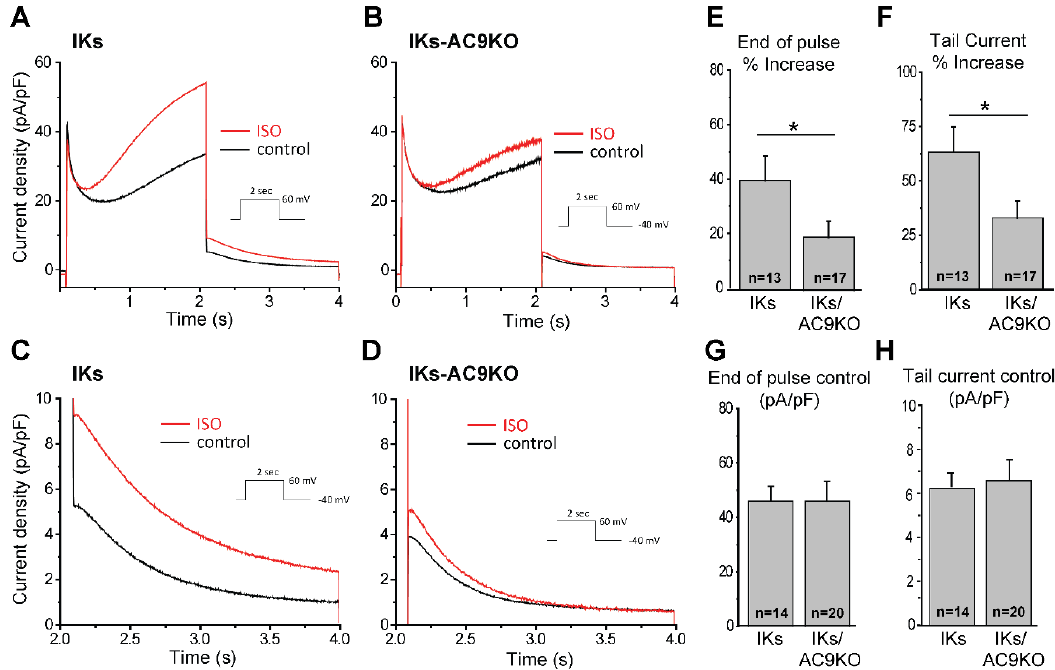
Figure 3. Deletion of AC9 dampens isoproterenol stimulation of I Ks . Representative traces of I Ks recordings in ventricular myocytes isolated from IKs ( A ) and IKs-AC9KO mice ( B ) before (control) and after perfusion of isoproterenal and okadaic acid (ISO). Enlargement of I Ks tail current in ventricular myocytes isolated from IKs ( C ) and IKs-AC9KO mice ( D ) before (control, black line) and after perfusion of isoproterenol and okadaic acid (ISO, red line). Increase in I Ks current at the end of pulse at + 60 mV ( E ) and in the tail current ( F ) in myocytes from IKs and IKs-AC9KO in control and after 1 µM isoproterenol and 1 µM okadaic acid. Total I Ks density at the end of the 2 sec pulse at + 60 mV ( G ) and I Ks tail density ( H ) in IKs and IKs-AC9KO ventricular myocytes was unchanged. Statistics: t-test, * p < 0.05, (Mann-Whitney), number of cells is indicated on the figure for each